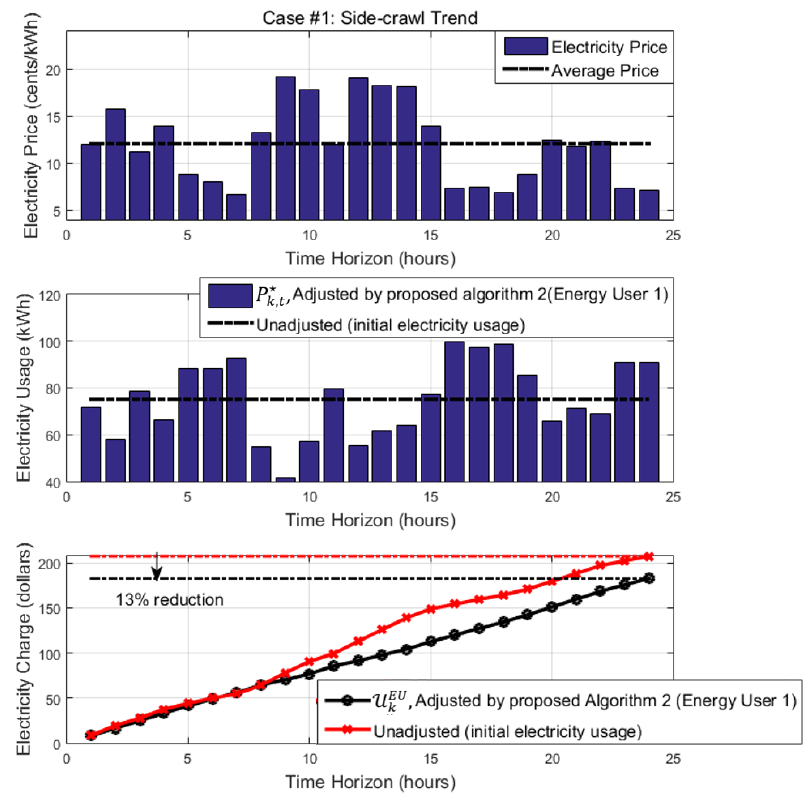
Figure 5. Electricity price with time (Case #1: side-crawl trend) and the electricity usage adjusted accordingly, and the confirmation of the electricity-charge saving. Energies 2017 , 10 , x FOR PEER REVIEW